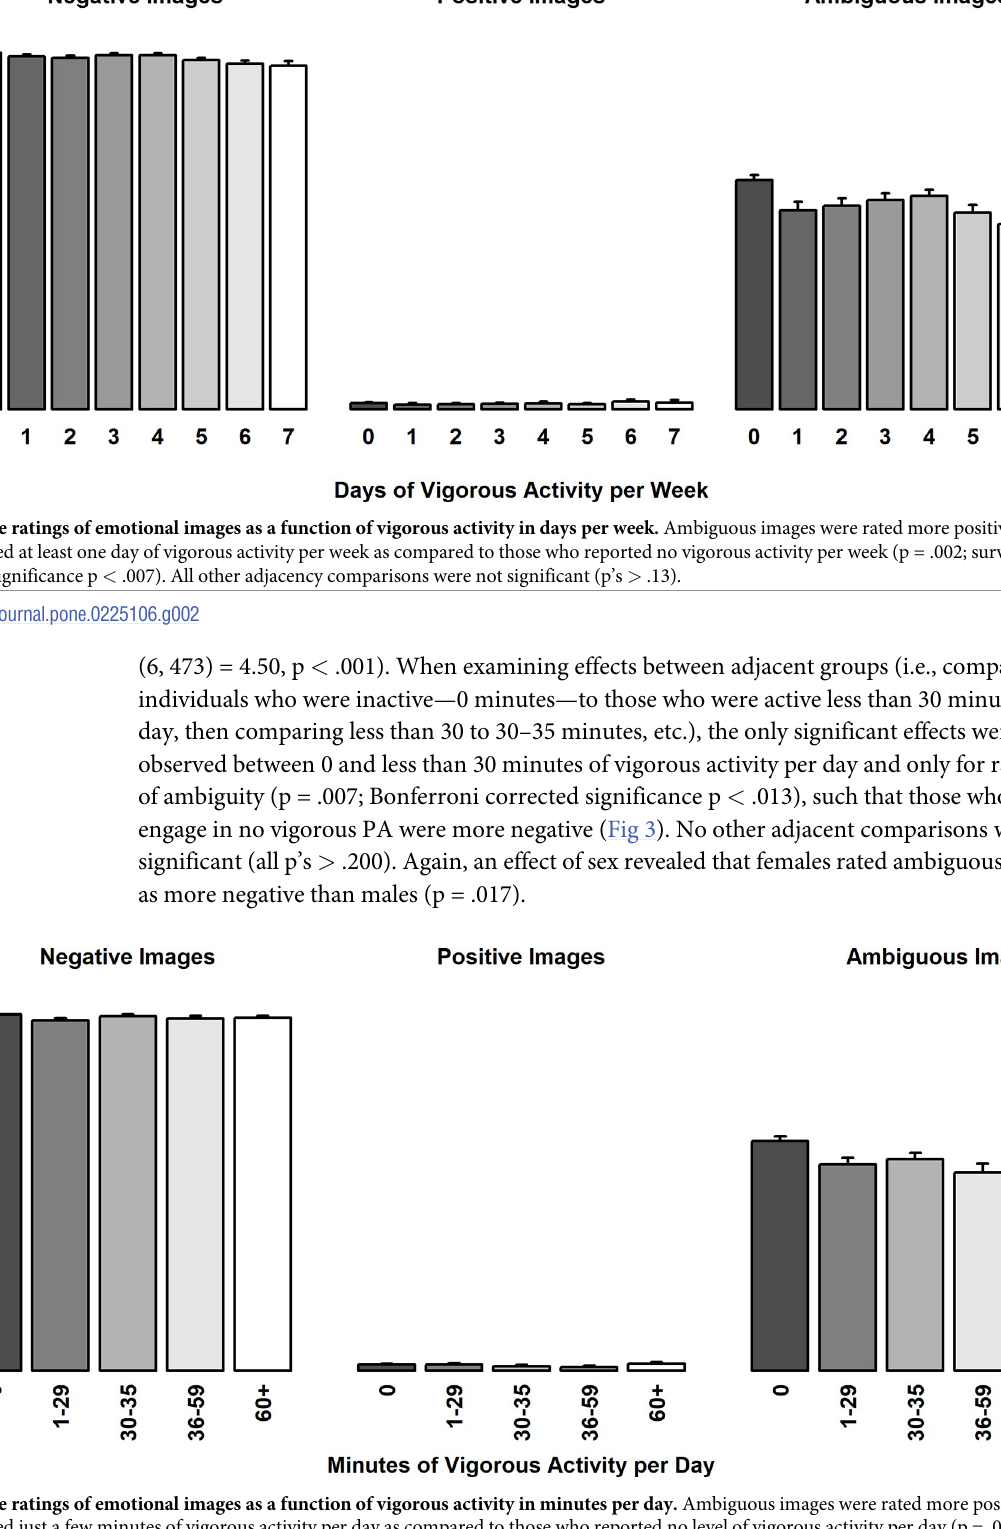
PLOS ONE | https://doi.org/10.1371/journal.pone.0225106 November14,